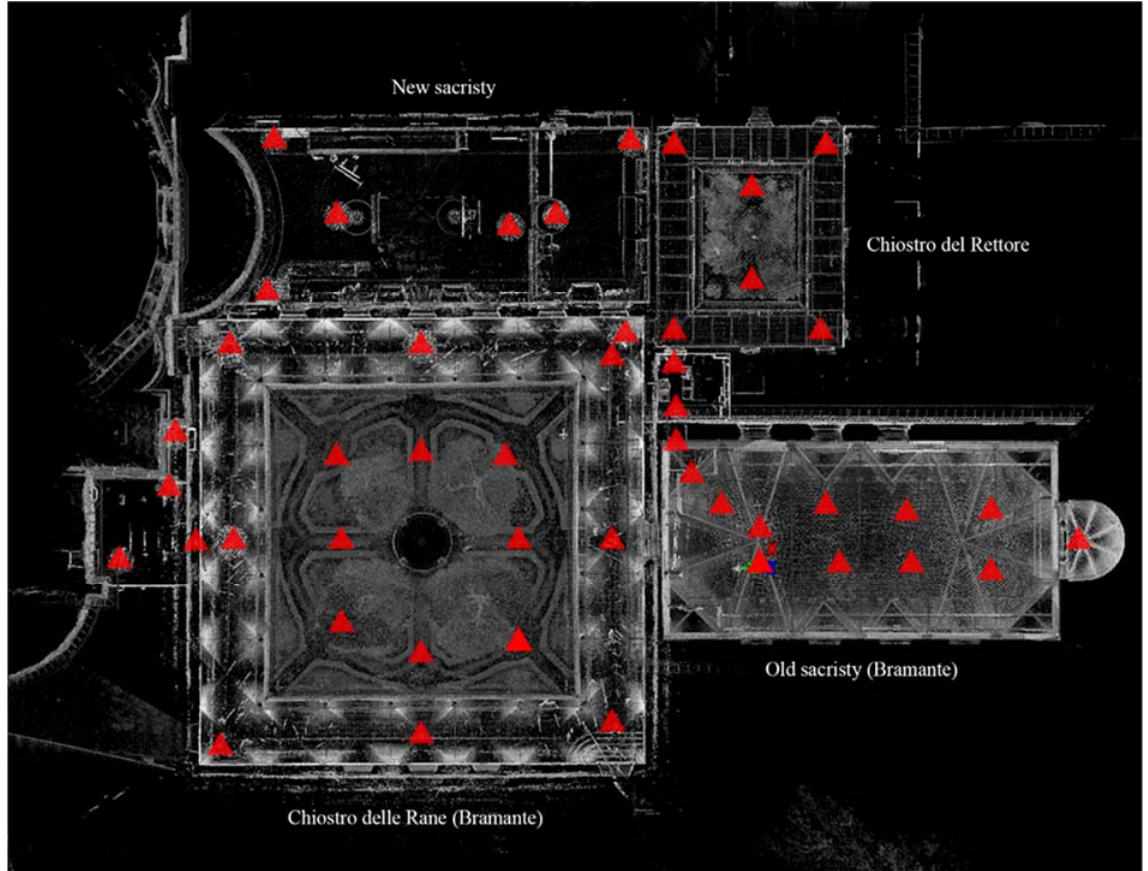
Figure 5. The scan stations performed for the TLS survey of areas of interest of Santa Maria delle